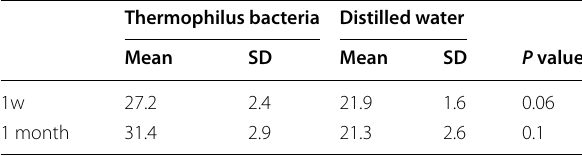
Table 1 Mean and standard deviation of the sealing ability of the experimental material in both